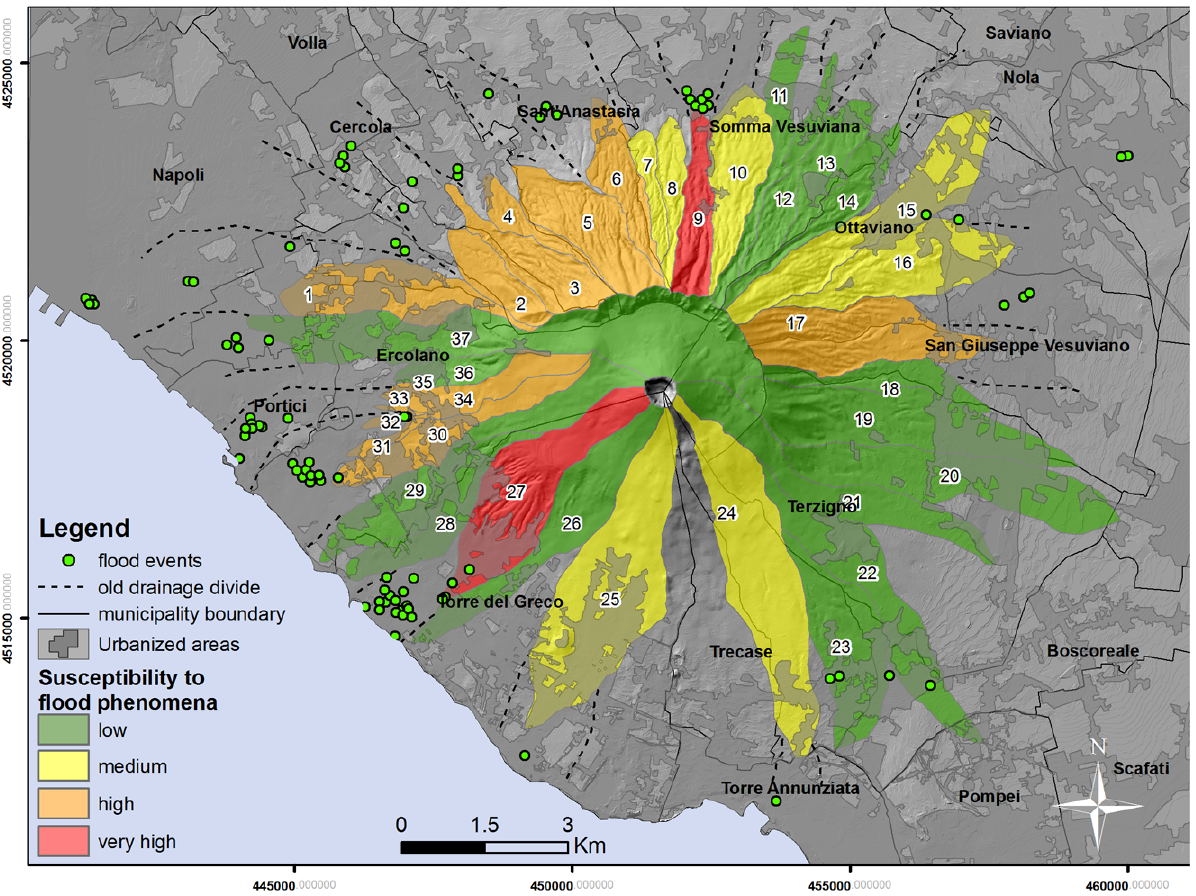
Figure 16. Preliminary zoning of the susceptibility of the Somma-Vesuvius district to flood